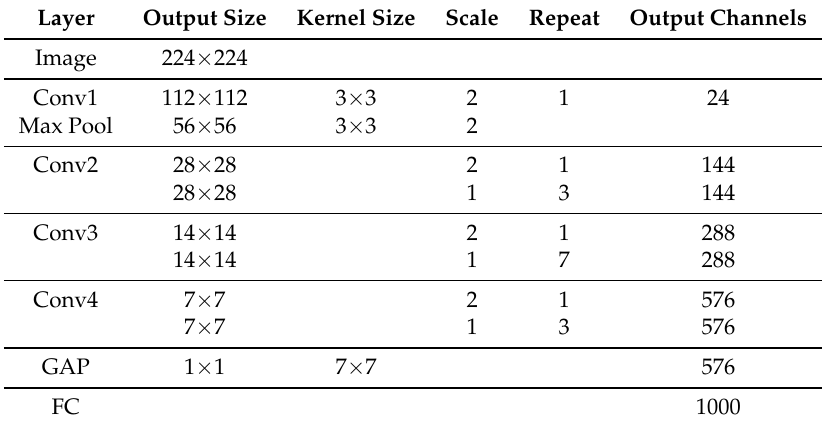
Table 1. The detail architecture of Xception like backbone used in our detection and keypoints network.